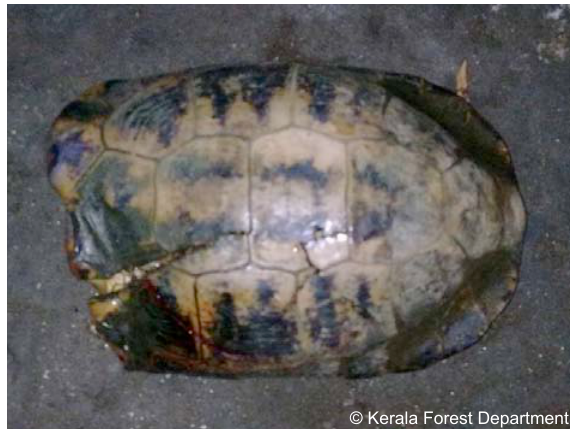
Image 3. An Indotestudo travancorica perceived to be dead from trampling by an elephant at Athirapilly Forest Division